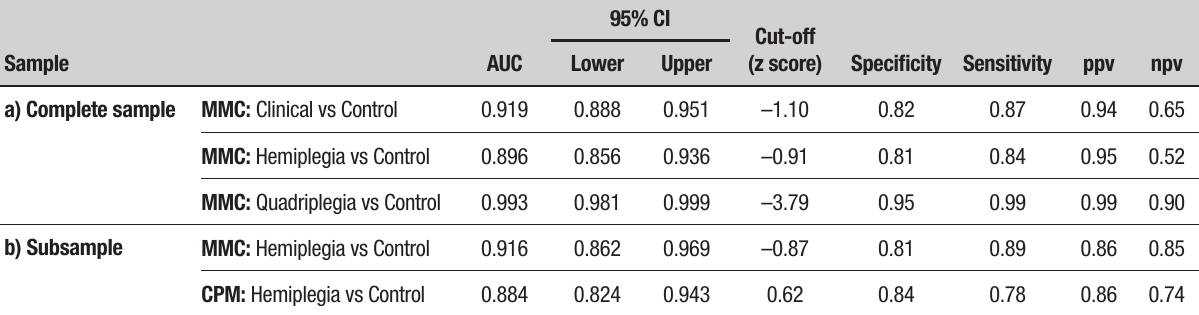
Table 2. Diagnostic accuracy of MMC and CPM.